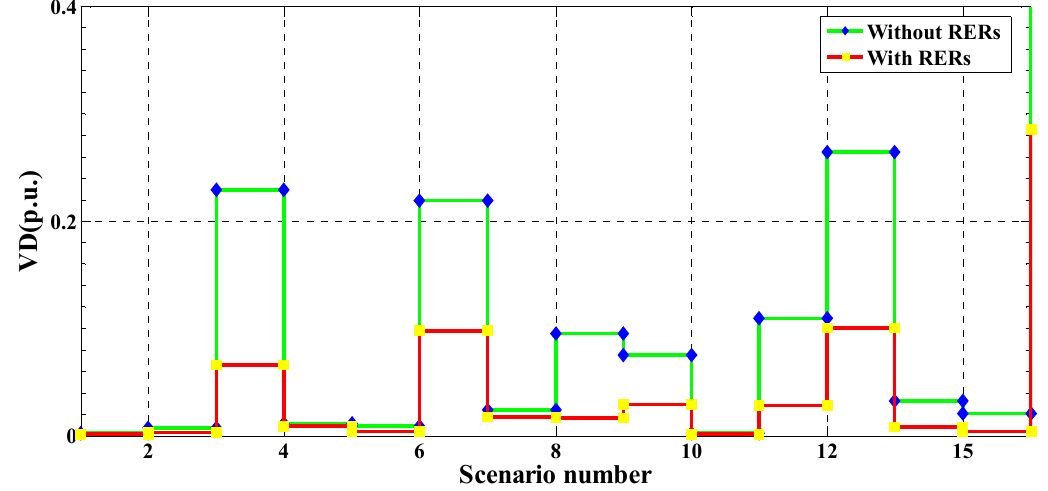
Figure 16. The 51-bus system VDs.